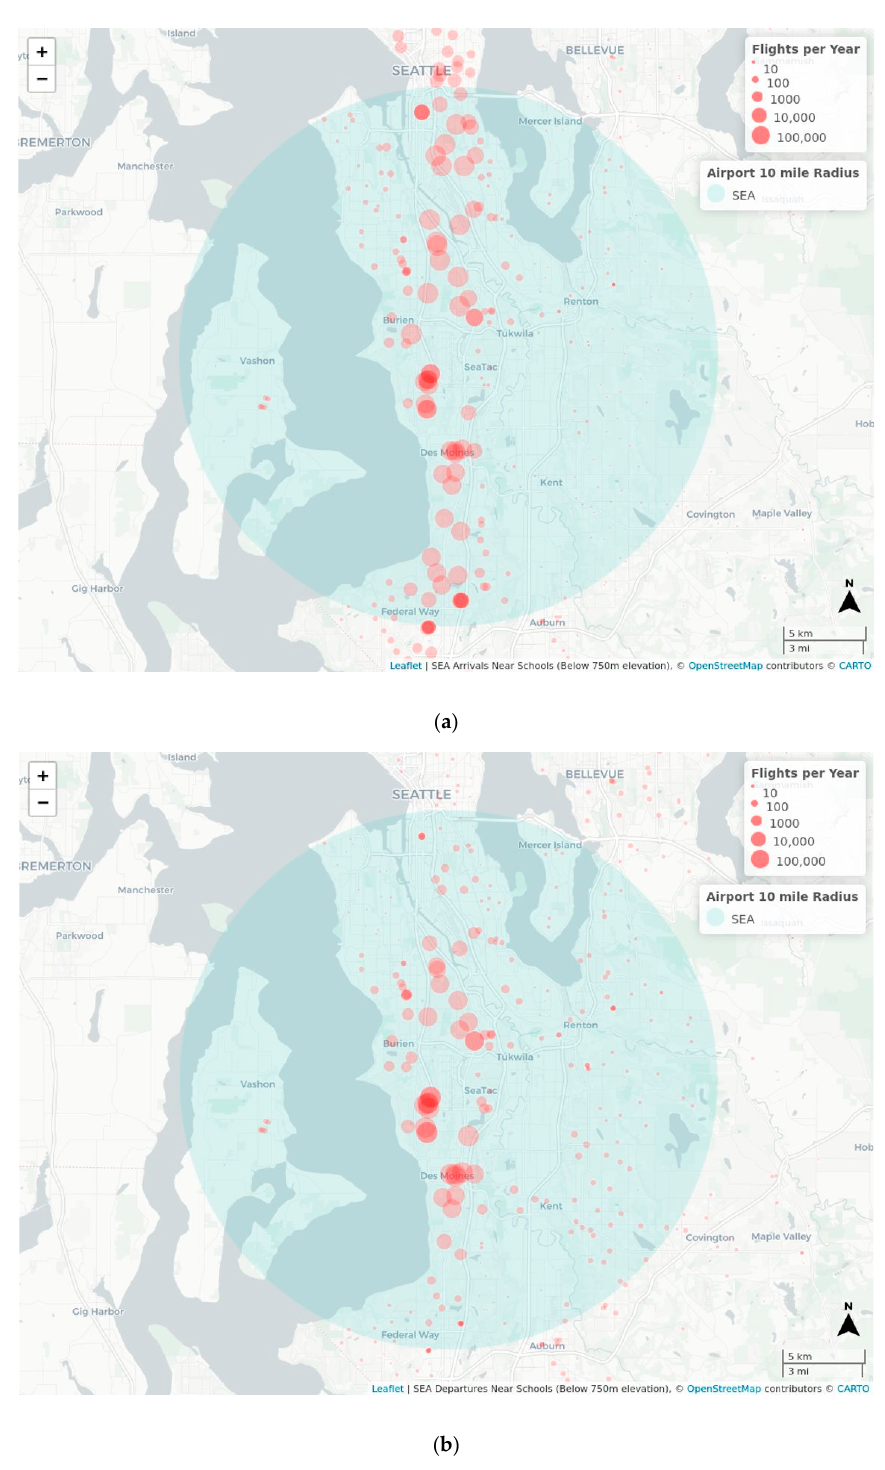
Figure 9. Number of flights in 2019 below 750 m and within a one-mile radius of a school. ( a ) Number of Sea-Tac Airport arrivals with overlay of the 10-mile radius for Sea-Tac Airport. ( b ) Number of Sea-Tac airport departures with overlay of the 10-mile radius for Sea-Tac Airport. An